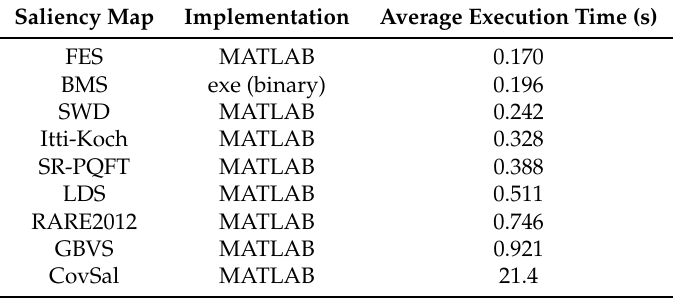
Table 12. Average execution time for saliency maps computation per frame of movie in the third experiment.